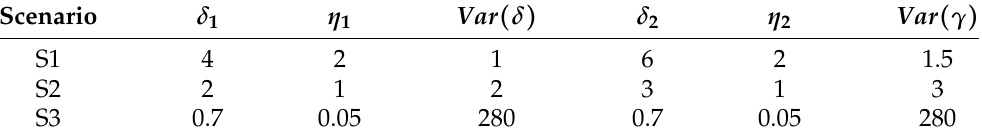
Table 1. The hyper-parameters of the prior distributions for Monte Carlo